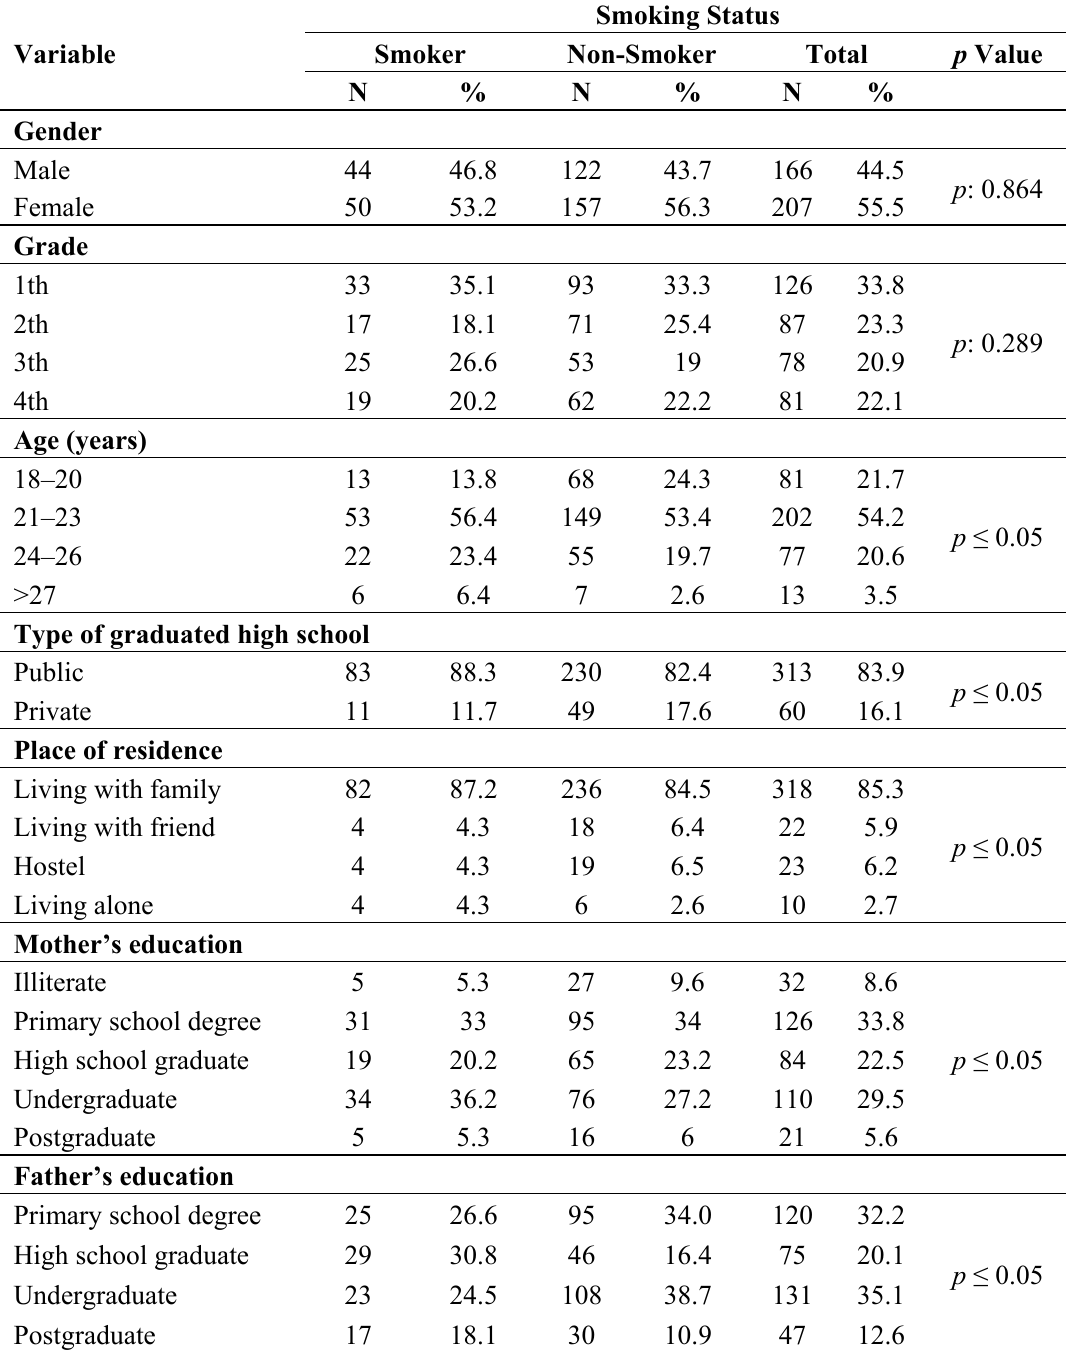
Table 1. Socio-demographic characteristics and smoking status of